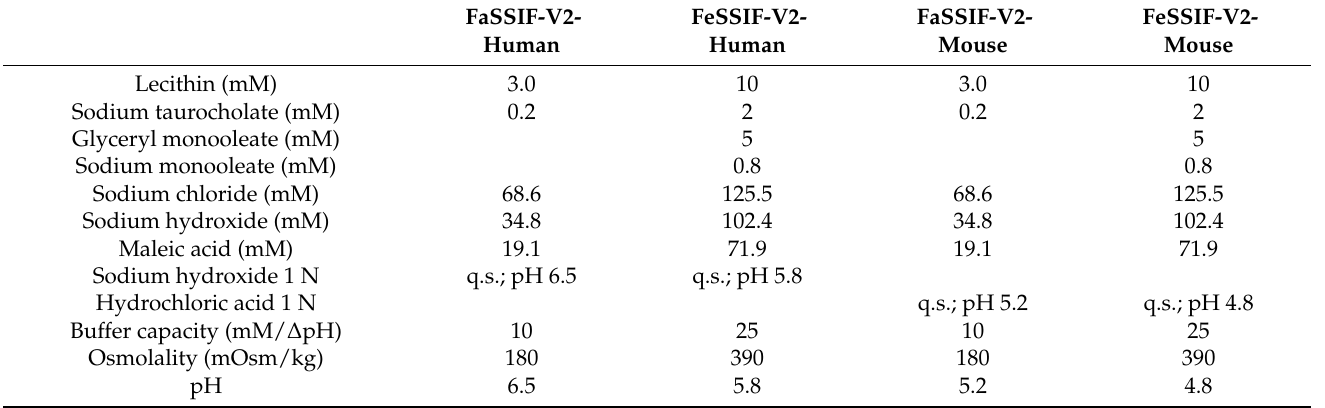
Table 1. Composition and physicochemical characteristics of biorelevant media simulating the small intestine environment in human and mouse in fasted and fed